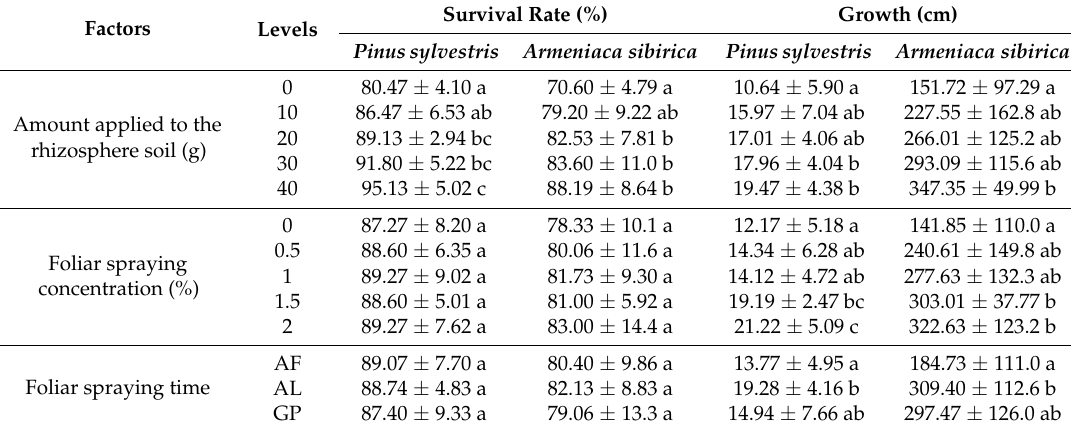
Table 4. Effect of the application of yeast extract on the survival rates (%) and growth (m) of Pinus sylvestris and Armeniaca sibirica . AF, After Forestation; AL, After Leafing; GP, middle of the growth period. Averages with no common letters have a significant difference at the 0.05